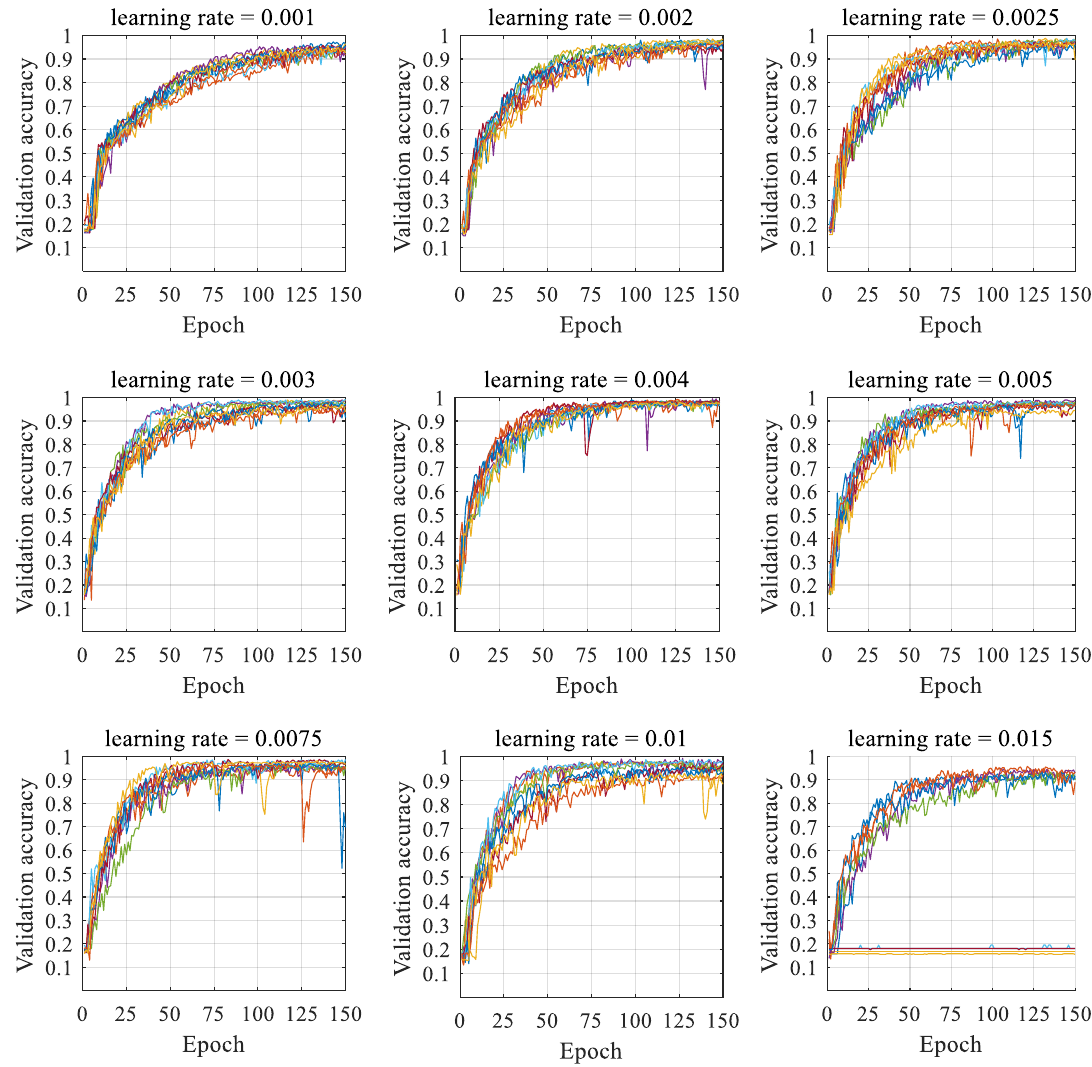
Figure 16. Illustration of the effect of the learning rate on convergence speed and convergence stability of the